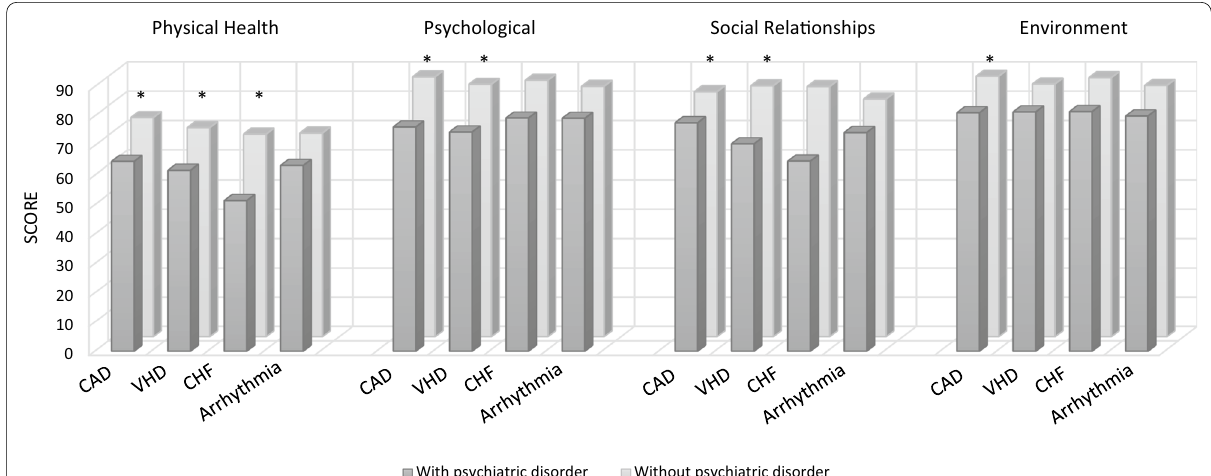
Fig. 1 WHOQOL-BRIEF domains of each cardiac disease with and without psychiatric disorders. CAD coronary artery disease, VHD vulvular heart disease, CHF congestive heart failure, WHOQOL-BRIEF the World Health Organization Quality of Life Brief Questionnaire.* indicates statistically significant